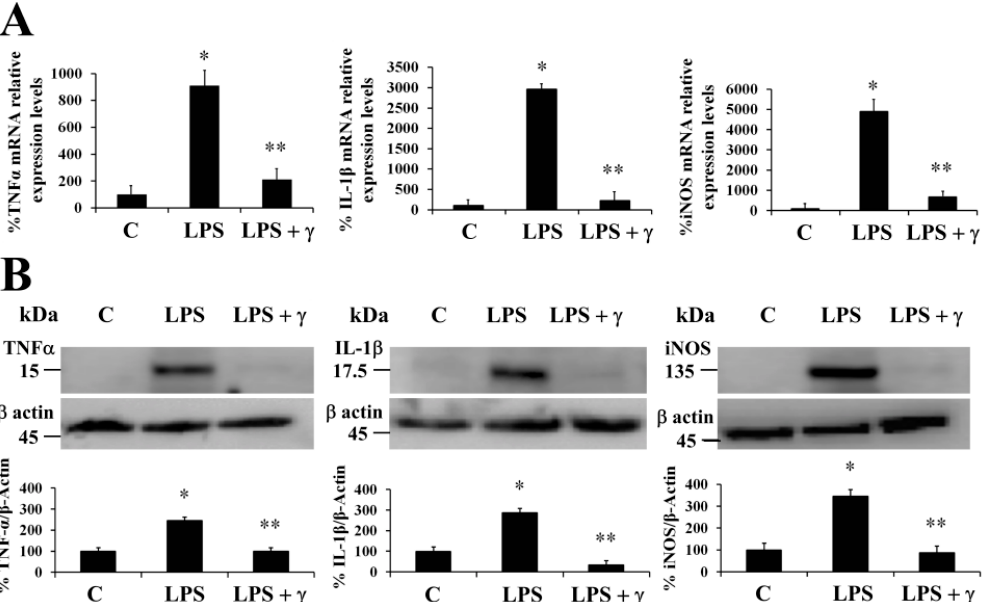
Figure 1. Narrow-leafed lupin (NLL) γ -conglutin decreases the mRNA expression and protein levels of TNF α , IL-1 β , and iNOS on lipopolysaccharide (LPS)-induced inflammation pancreatic cells. PANC-1 cells were incubated for 24 h with LPS alone or γ -conglutin + LPS. ( A ) The bar graph shows mRNA levels determined by real-time RT-qPCR of TNF α , iNOS, and IL1 β . ( B ) The bar graph shows protein levels determined by immunoblotting of TNF α , iNOS, and IL1 β . Average value from triplicate experiments of each biomarker were relativized to the average value of their housekeeping actin protein in control samples. Then, average values from challenge experiments (calculated in the same way than controls) are relativized to these from their respective control values previously calculated. Data represent mean ± SD from three independent experiments. C: Untreated control culture cells; LPS: LPS-treated culture cells; LPS + γ : LPS + γ -conglutin challenge. p < 0.05 represents statistically significant differences associated with each figure. p * < 0.05 LPS versus C; p ** < 0.05 LPS + γ -conglutin versus LPS. Challenges were made with LPS and/or γ -conglutin protein at 1 μ g/mL and 25 μ g, respectively.